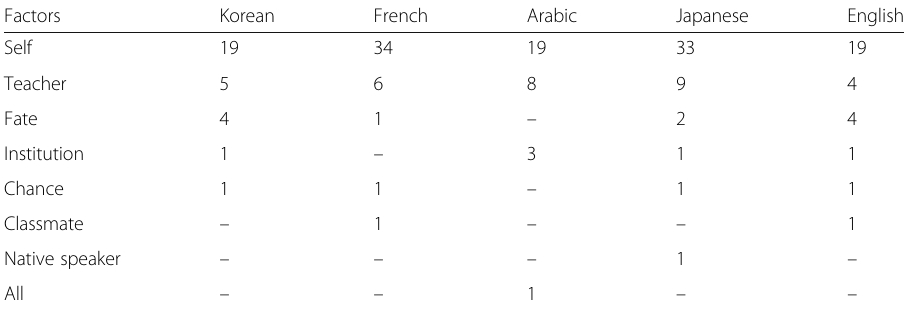
Table 10 Perceived responsible for the anxiety Factors